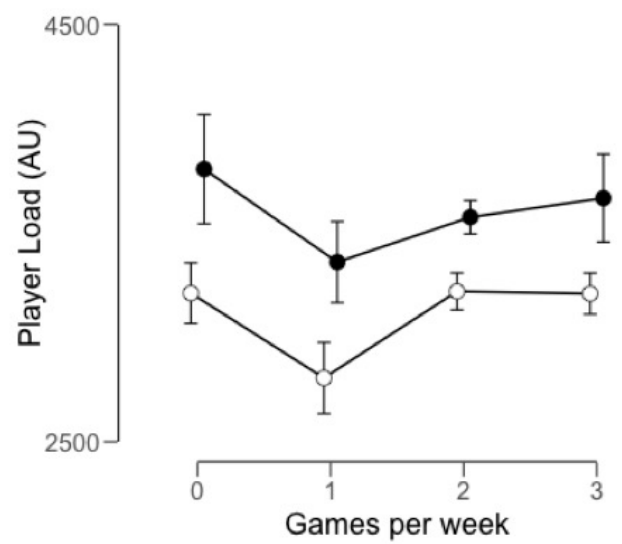
Figure 3. Average PlayerLoad values in arbitrary units (AU) by the number of games played within a week and for the seasons 2017–2018 (o) and 2018–2019 ( ● ). Error bars represent the SD of each of the four groups separately.